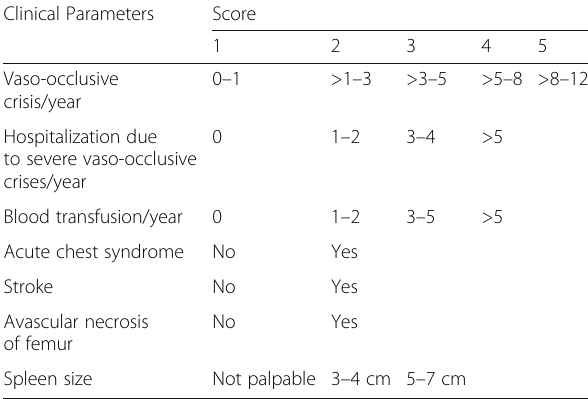
Table 1 Scoring system for clinical evaluation of sickle cell patients.11